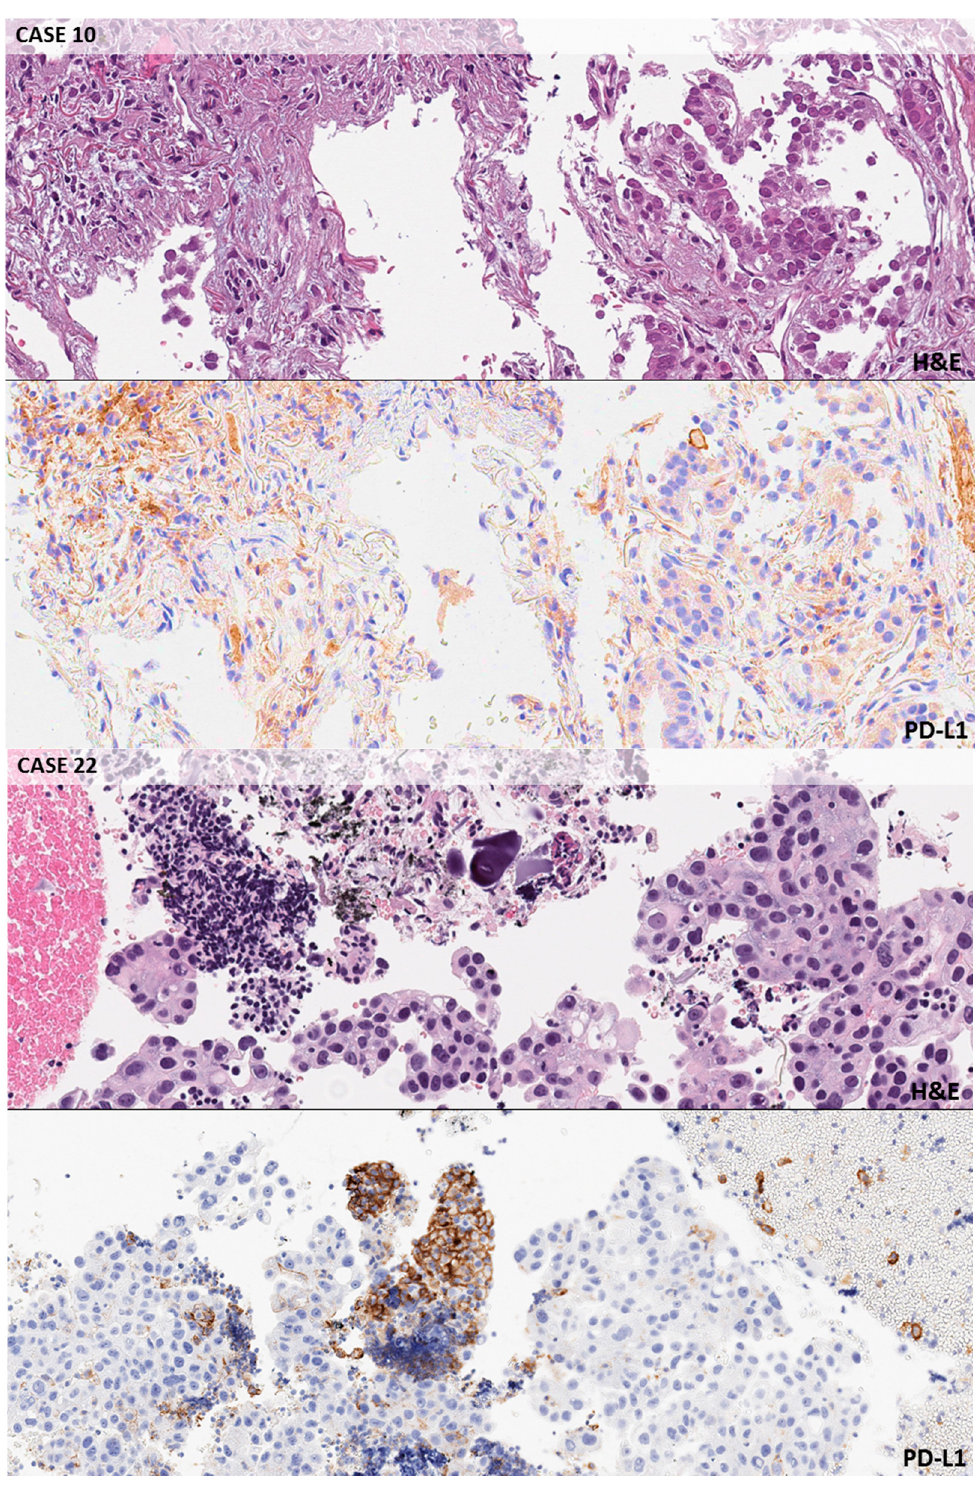
Figure 1. Negative cases. Exemplificative false positive background in macrophages and inflammatory cells in a lung biopsy. Case n. 10 (original magnification 10×, 22c3): PDL1 TPS < 1%; look at the background staining in macrophages peritumoral cells. CASE n. 22 (10×, 22c3): PDL1 TPS < 1%; the application of a careful magnification rule allows to classify as macrophages this group of PD-L1 strong positive